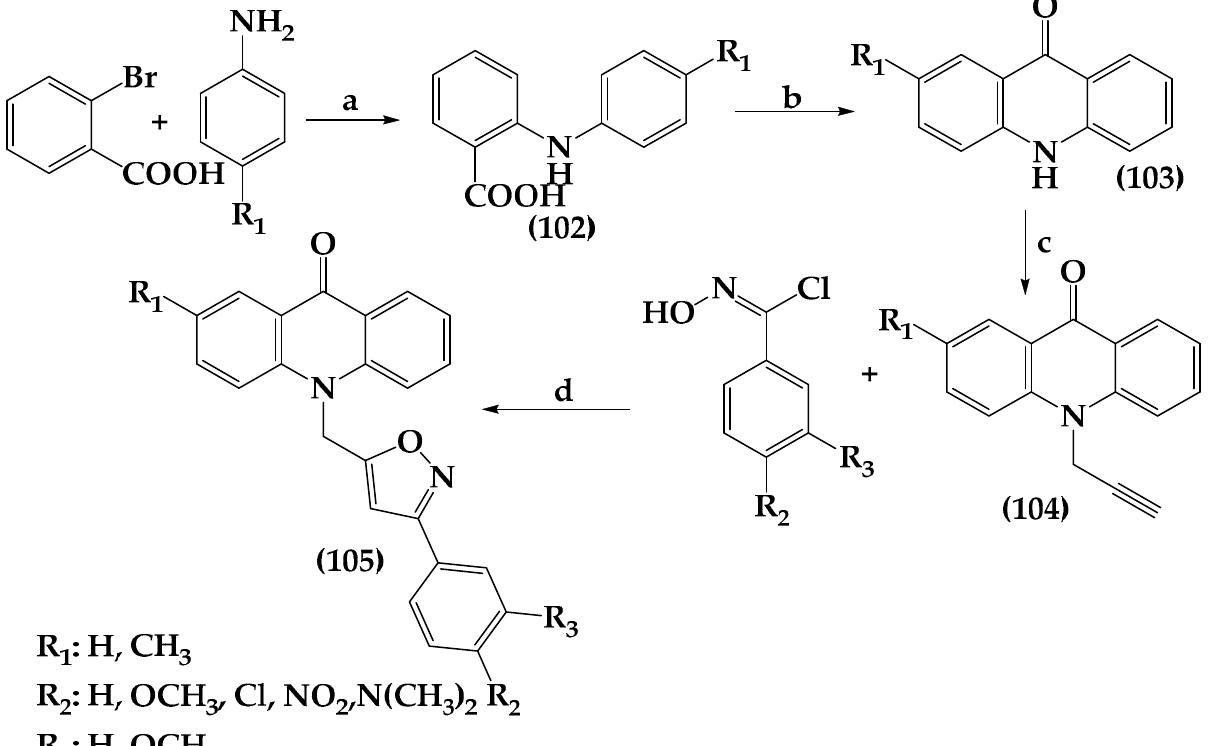
Scheme 6. Synthesis of isoxazole-acridone derivatives ( 105 ). Reagents and conditions: (a)